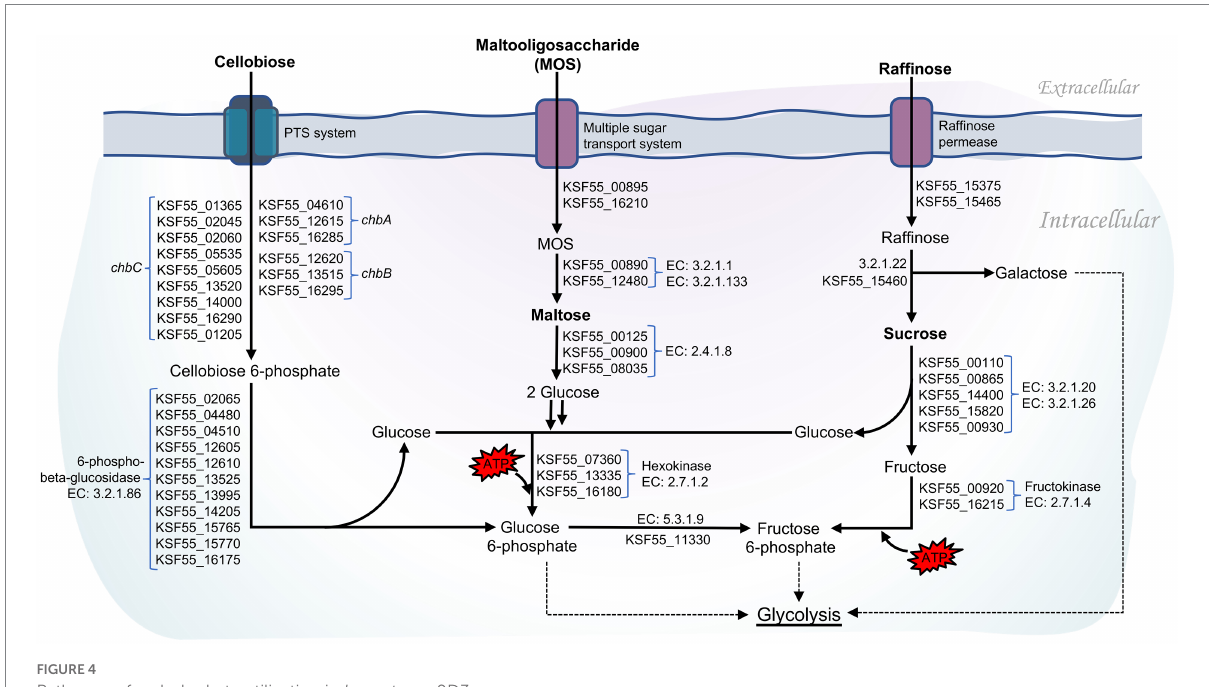
FIGURE 4 Pathways of carbohydrate utilization in L. pentosus 9D3.